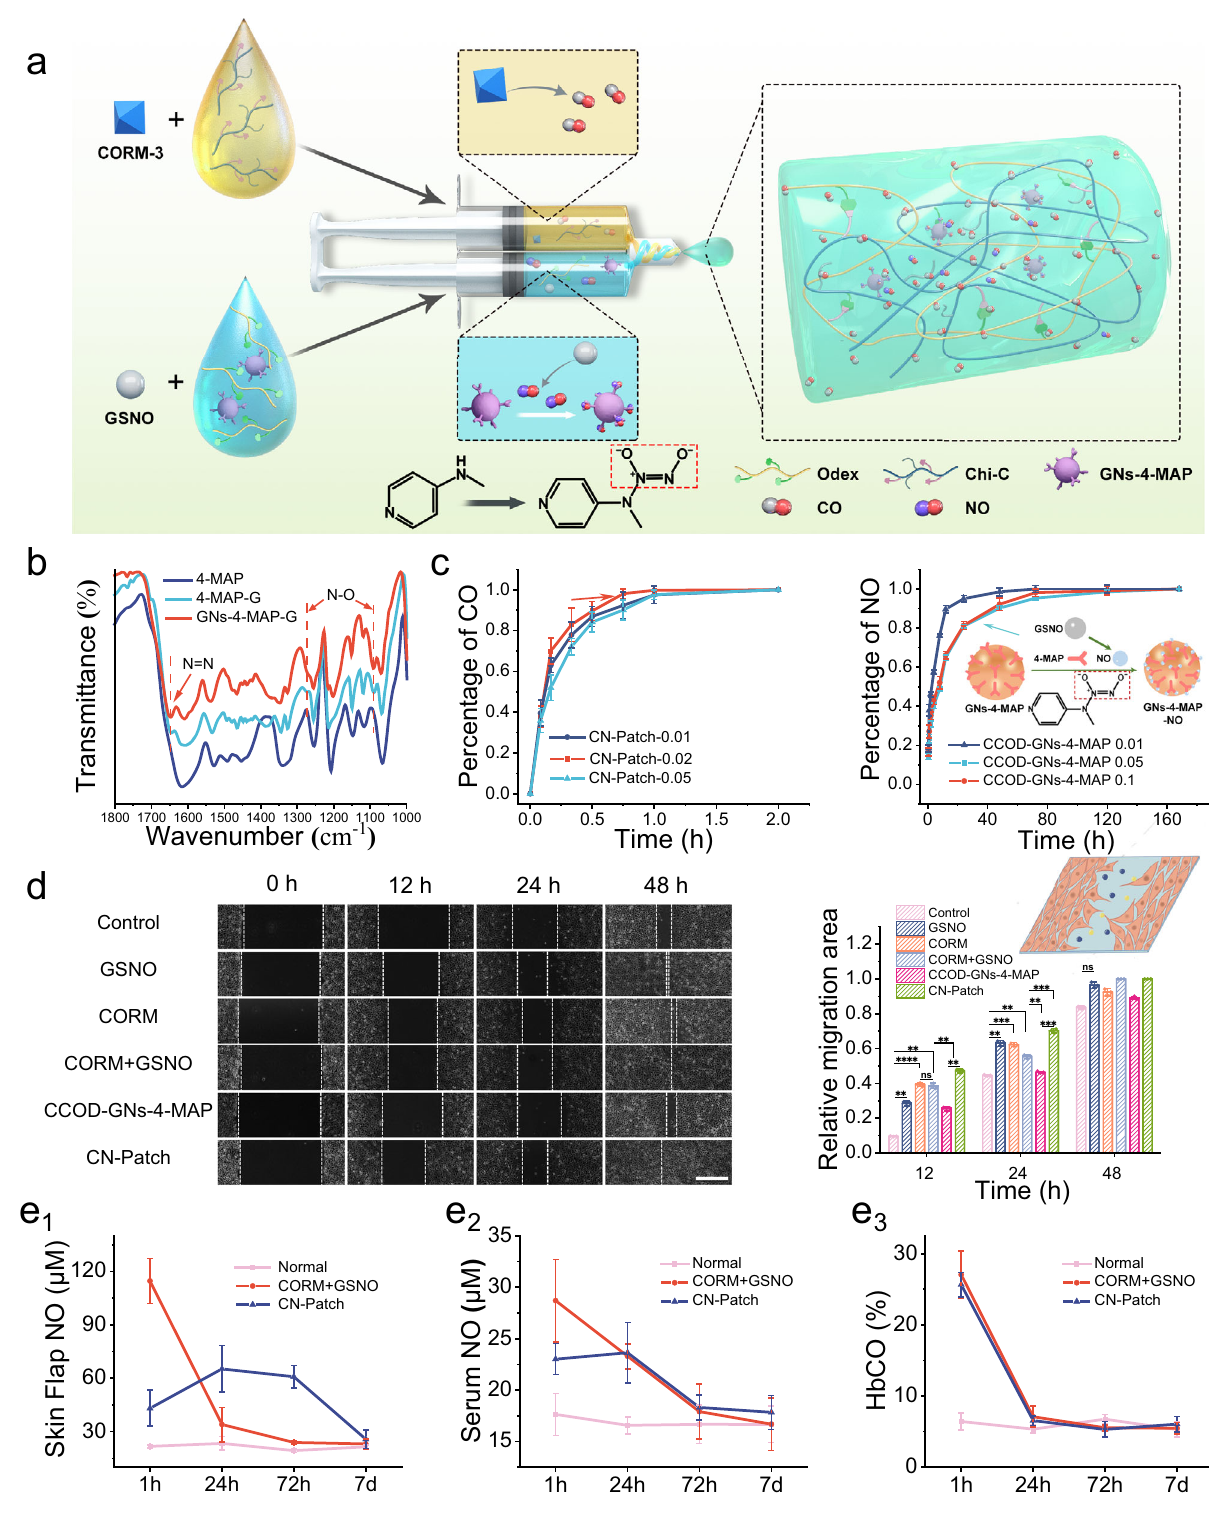
Fig. 2 | Characterization of the release effect of gas molecules in hydrogels. a The Schematic of the design strategy of the CN-Patch hydrogel. b The infrared spectra of the 4-MAP, 4-MAP-NO and GNs-4-MAP-NO, measured using a BLUCK spectrophotometer within 500 – 4000cm − 1 . c CO and NO release study in vitro, measured using colorimetry and a NanoDrop Microvolume Spectrophotometer (ThermoFisher Scienti fi c) (mean±SEM, n =6 samples per group). d The photo of (humanumbilicalveinendothelialcells)HUVECscellmigration.Scale bar:500 μ m.